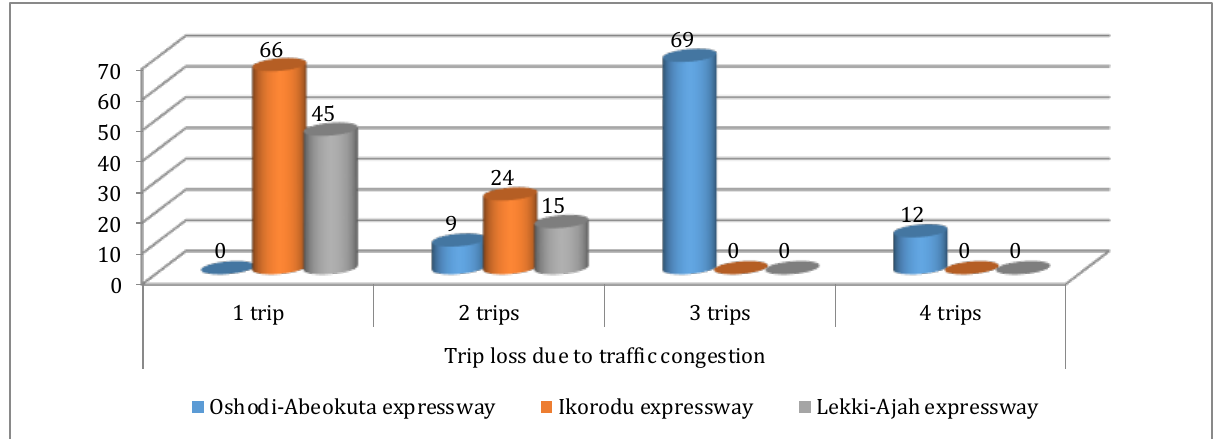
Figure 3: Distribution of Daily Trips loss by Bus Operators across the Three Highways of